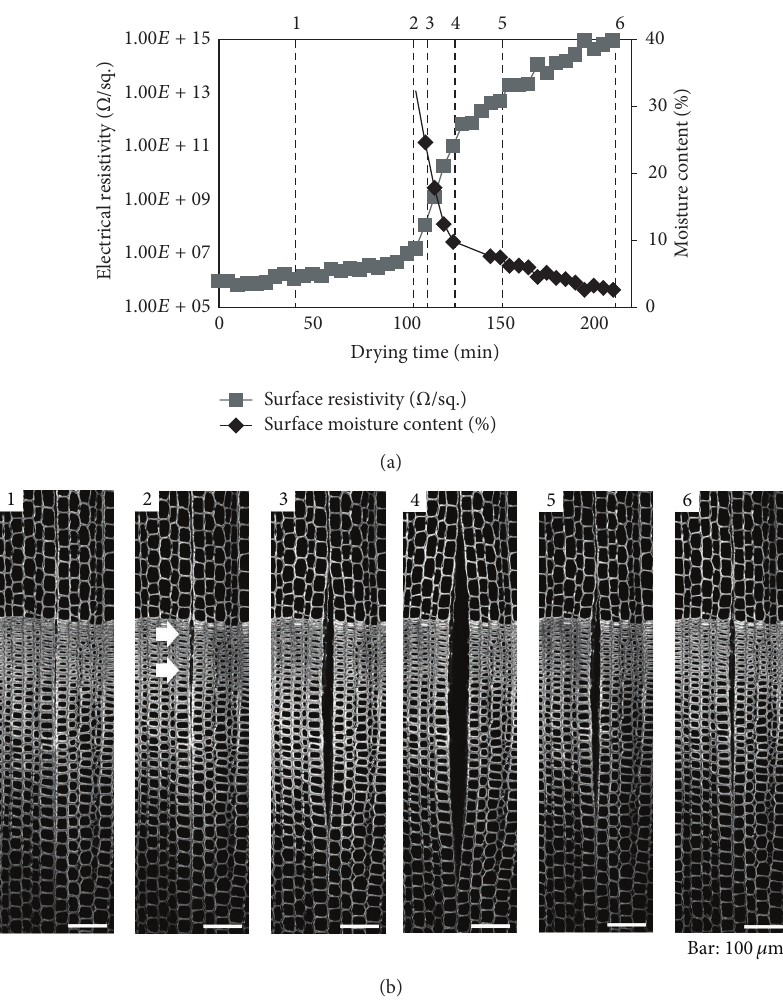
Figure 5: Sequential images showing propagation of microcrack in relation to surface electrical resistivity and surface moisture content calculated from regression equations: (1) before microcrack emerges, surface moisture content was above FSP, (2) immediately after microcrack emerges, surface moisture content was around FSP, (3) microcrack develops, (4) largest microcrack, (5) microcrack closes, and (6) residual